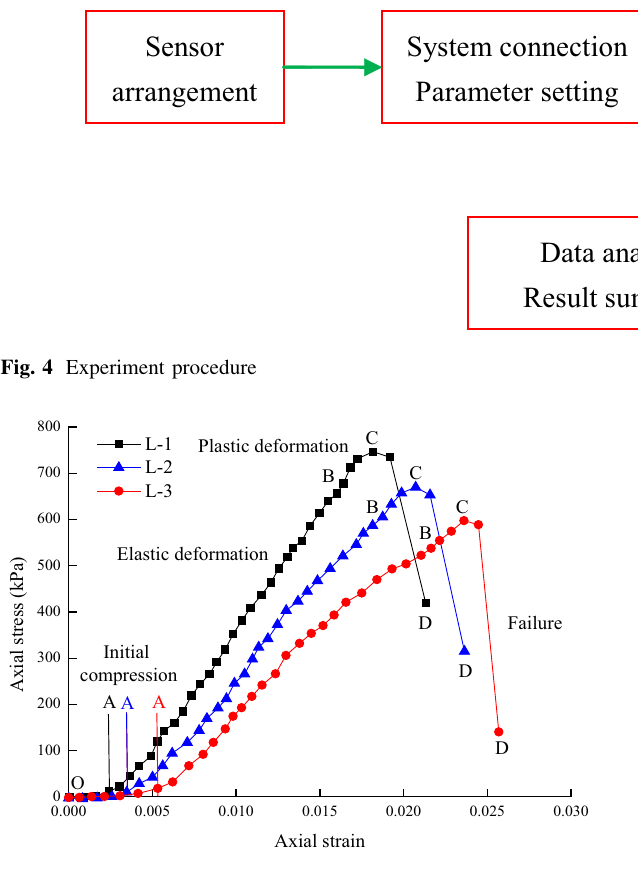
Fig. 5 The stress–strain curves Fig. 6 The change of the peak strength and residual strength